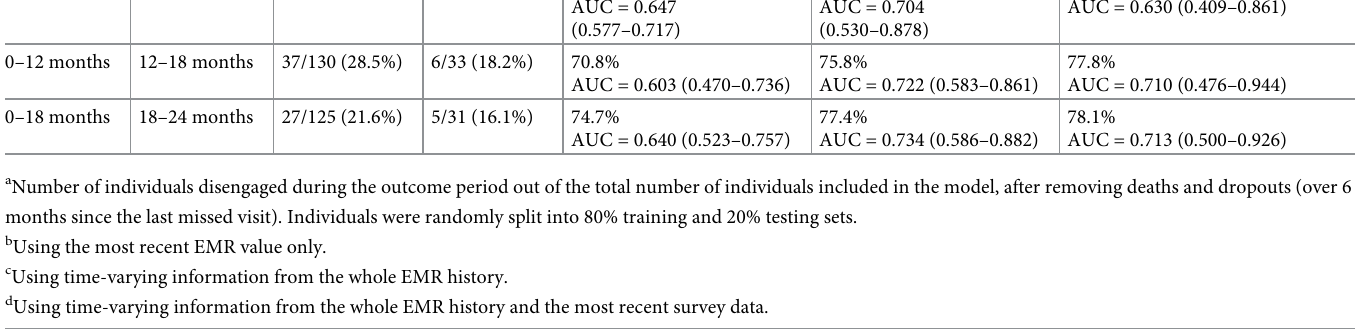
Table 2. Accuracy of predicting disengagement from HIV care in the next 6 months, Shinyanga, Tanzania, 2018–2021.